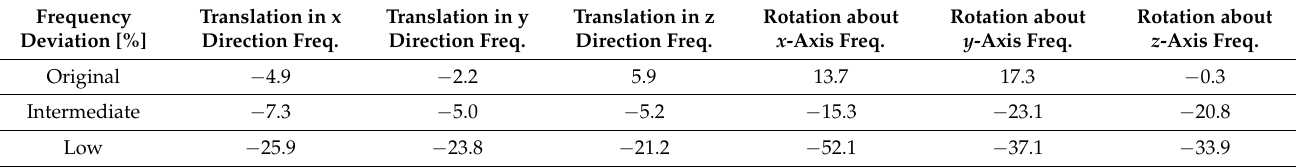
Table 5. Summary of the Frequency deviation [%] between Barkan’s theory and FEA in the different geometries of the foundations. Frequency Translation in x Translation in y Deviation [%] Direction Freq. Direction Freq.